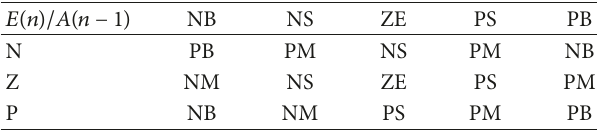
Table 1: Rules of MPPT fuzzy